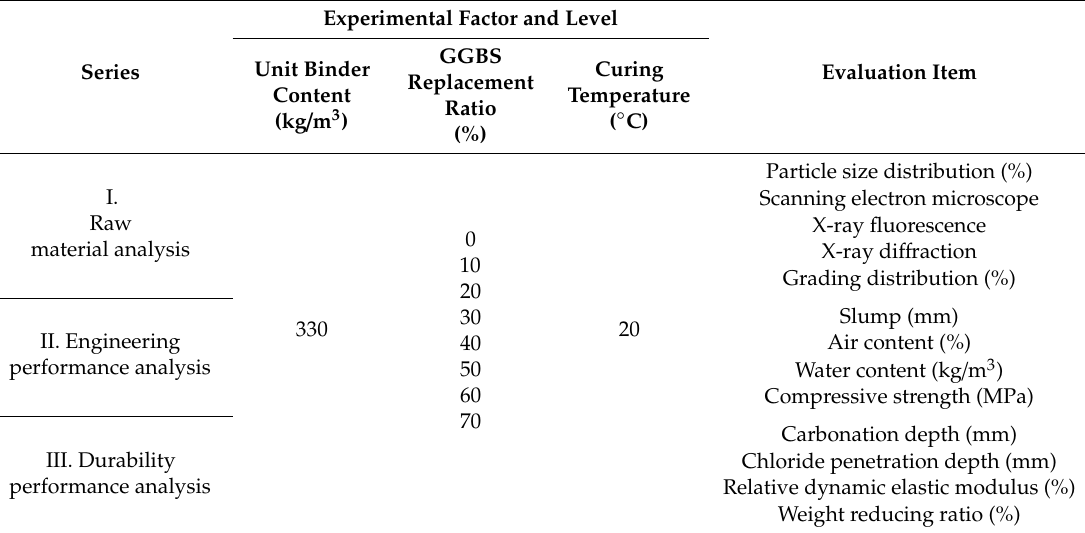
Table 3. Experimental plan.